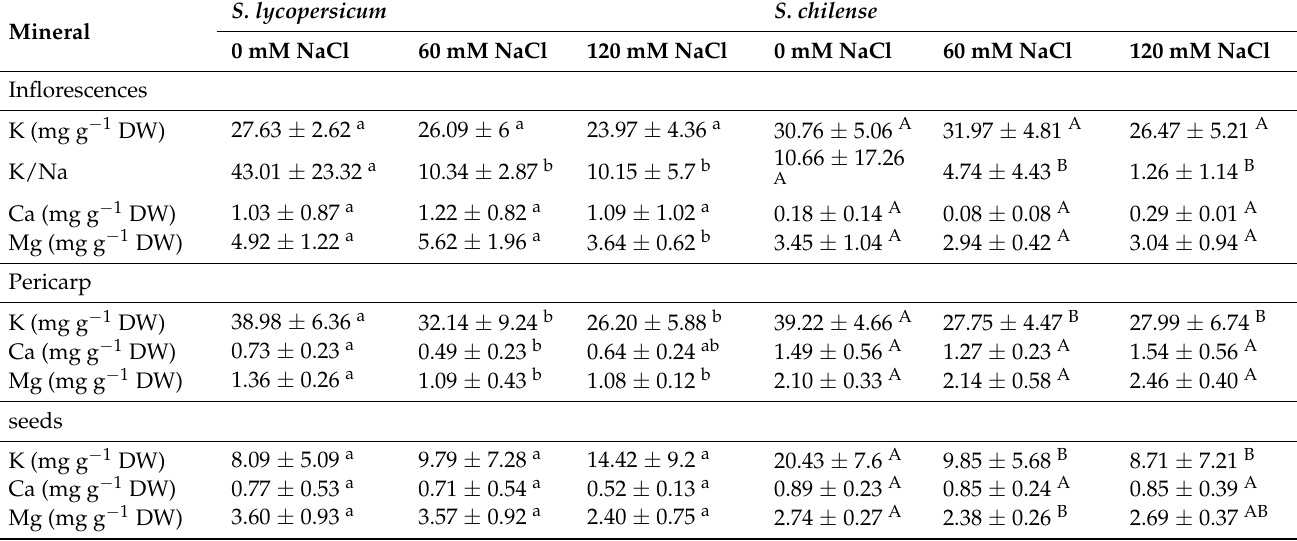
Table 5. Effects of salt stress K, Ca, and Mg concentrations of different organs of Solanum lycopersicum and Solanum chilense grown at 0, 60, and 120 mM